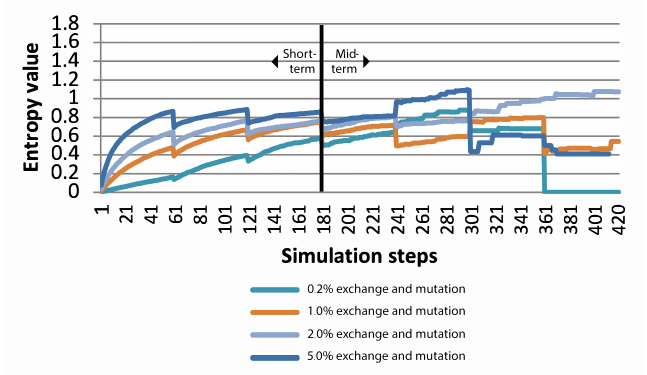
Figure 7. MPGA results applying mild SAWs of 72%.